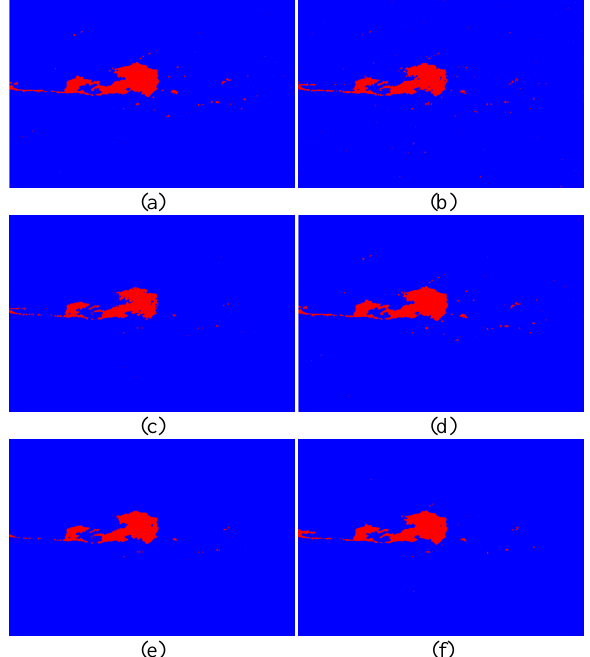
Figure 5. K-means classification of six polarimetric features in SIR-C Pr17041 images. (a) Dop ; (b) μ ; (c) A 12 ; (d) Ph ; (e) V ; (f) rrr s